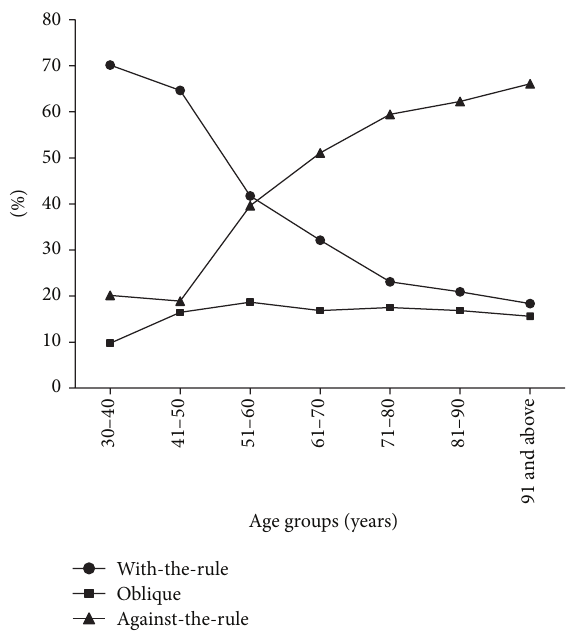
Figure 4: Percentages of WTR, ATR, and oblique corneal astigma- tisms in the 7